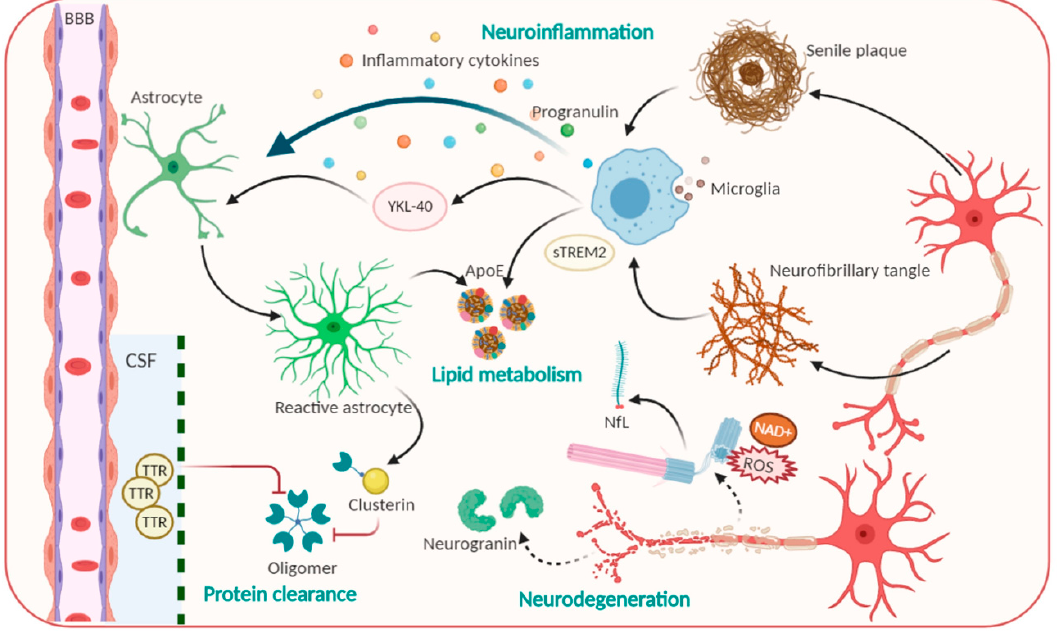
Figure 1. Pathophysiological processes including Amyloid beta, Tau and candidate non-A β -Tau biomarkers for Alzheimer’s disease. biomarkers for Alzheimer’s